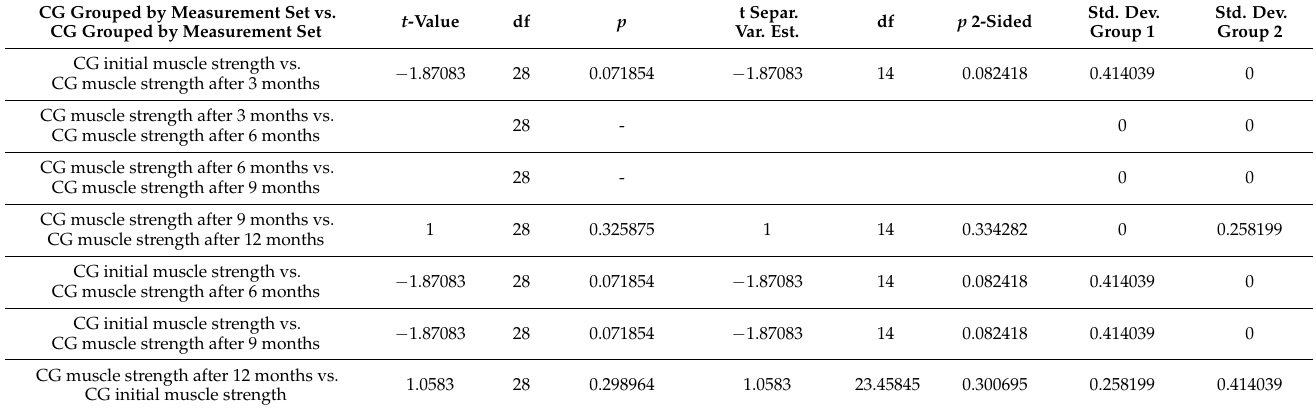
Table 6. T -test between CG muscle strength measurement sets of the patients.